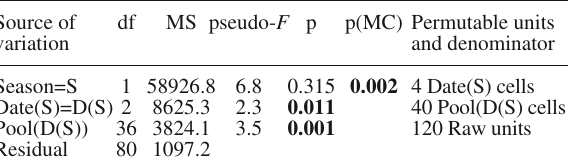
Table 1. – Permutational multivariate analysis of variance (PER- MANOVA) on rock pool assemblages. Significant effects are indi- cated in bold. P(MC)=p-value calculated by Monte Carlo method. Source of df MS pseudo- F p p(MC) Permutable units variation